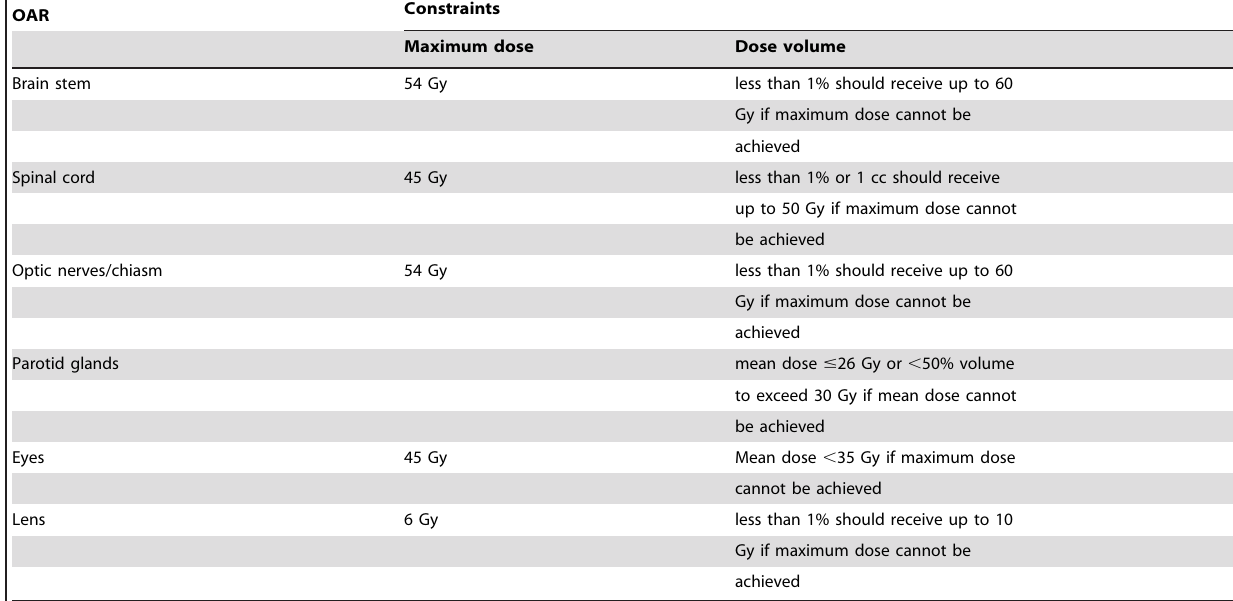
Table 1. Constraints to OARs.